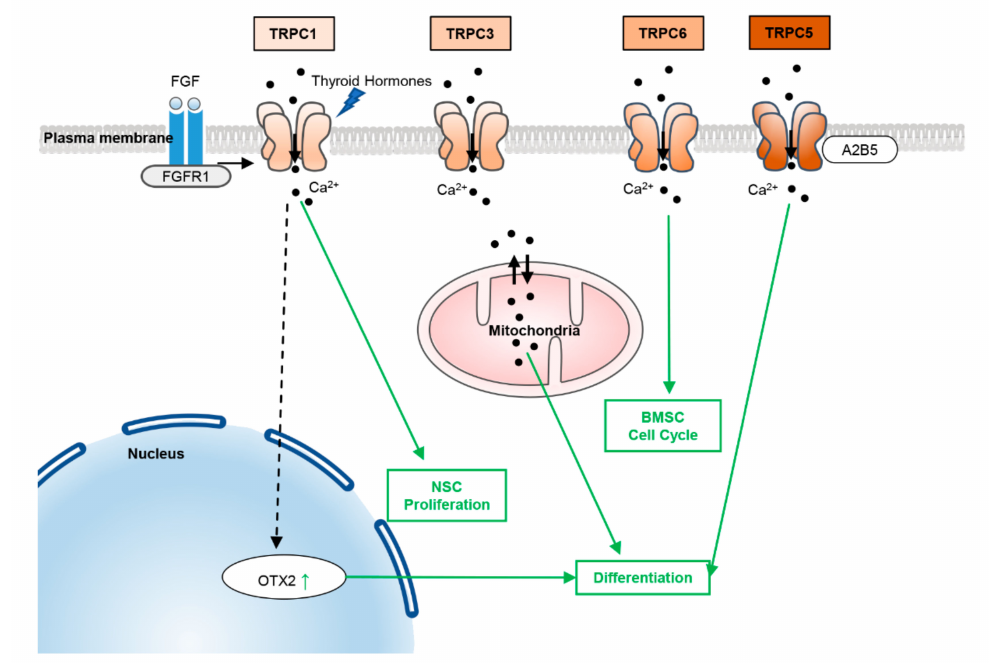
Figure 1. TRPCs function in stem cells. TRPC1-induced Ca 2+ influx activates the FGF/FGFR1 signaling pathway or OTX2 to promote proliferation or differentiation of NSCs. TRPC3 triggers Ca 2+ influx in mitochondria, which promotes the stabilization of differentiation processes of ESCs to NSCs. High expression of TRPC5 in A2B5 + NPCs with increased store-operated Ca 2+ entry promotes cell differentiation. Further, the dynamic distribution of TRPC6 can control the magnitude of store-operated Ca 2+ entry via changes in membrane potential to regulate the cell cycle of BMSCs. Studies indicate that TRPMs mediated stem cell differentiation and other biological roles via different signaling pathways with Ca 2+ involvement. The Ca 2+ influx induced by TRPMs can activate different cellular processes or adjust gene